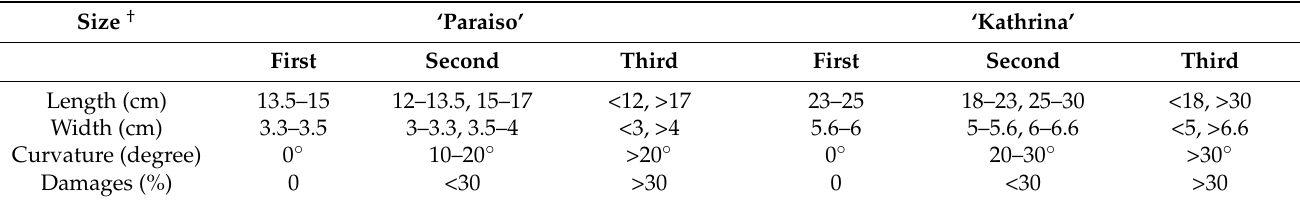
Table 3. Quality standards for cucumber fruits of the INTEBAJ commercial packinghouse.